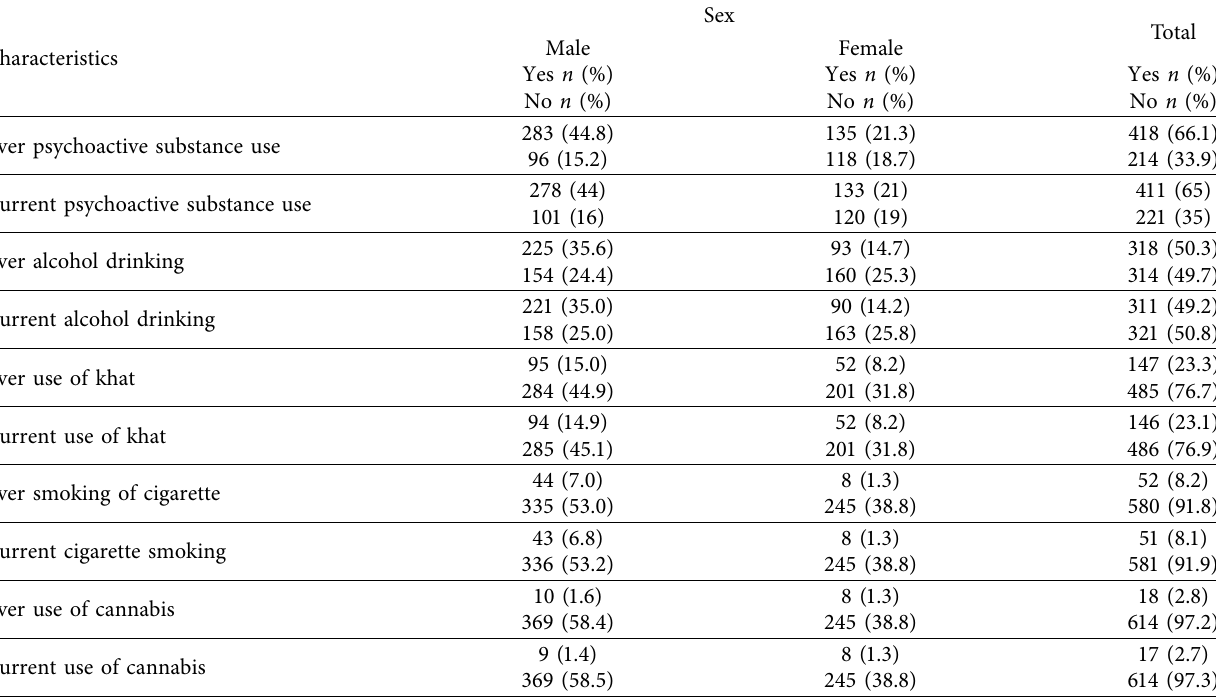
Table 2: Te prevalence of current and life time psychoactive substance use among youths in selected administrative towns, North Shewa zone, Amhara regional states, Ethiopia, 2020.